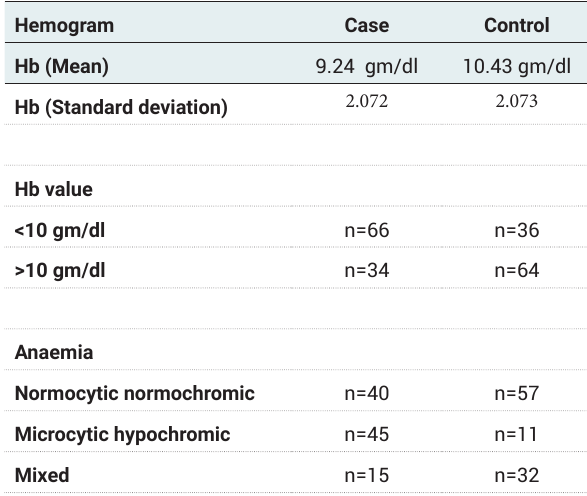
Table 4: Multivariate Logistic Regression Analysis Showing Anemia as a Risk factor of LRTI